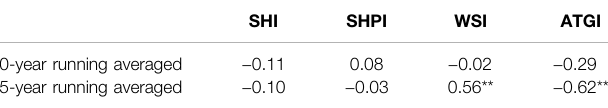
Frontiers in Environmental Science |